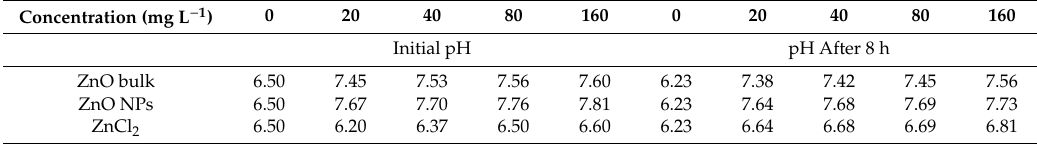
Table 1. pH values measured di ff erent solutions, before and after corn seed